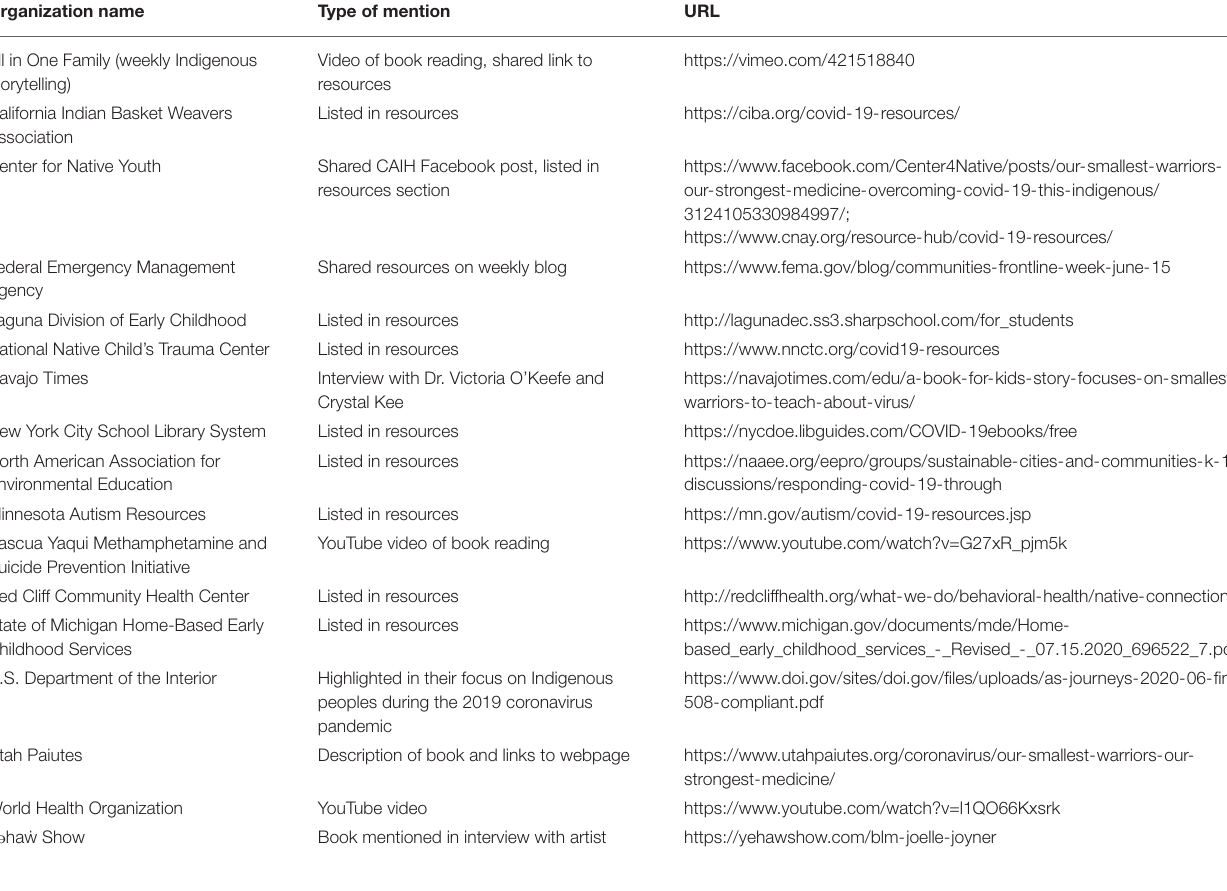
TABLE 1 | Organizations and communities sharing OSWOSM and